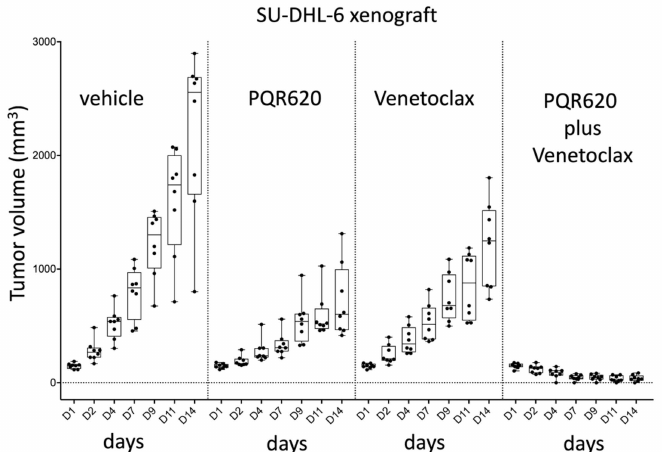
Figure 4. The combination of PQR620 and venetoclax have stronger in vivo anti-tumor activity than the single agents in a xenograft model of GCB-DLBCL. NOD-Scid mice subcutaneously inoculated with SU-DHL-6 (15 × 10 6 ) cells were split into four groups respectively treated with PQR620 (100 mg / kg, Qdx7 / w, po, n = 8), Venetoclax (100 mg / kg, Qdx7 / w, a combination of PQR620 with venetoclax ( n = 8) and control vehicle ( n = 8). PQR620 versus vehicle, D4–D14, p < 0.01; PQR620 + venetoclax versus vehicle, D2–D14, p < 0.01; PQR620 + venetoclax versus PQR620, D2–D14, p < 0.01; PQR620 + venetoclax versus venetoclax, D2–D14, p < 0.01. In each box-plot, the line in the middle of the box represents the median and the box extends from the 25th to the 75th percentile (interquartile range, IQ); the whiskers extend to the upper and lower adjacent values (i.e., ± 1.5